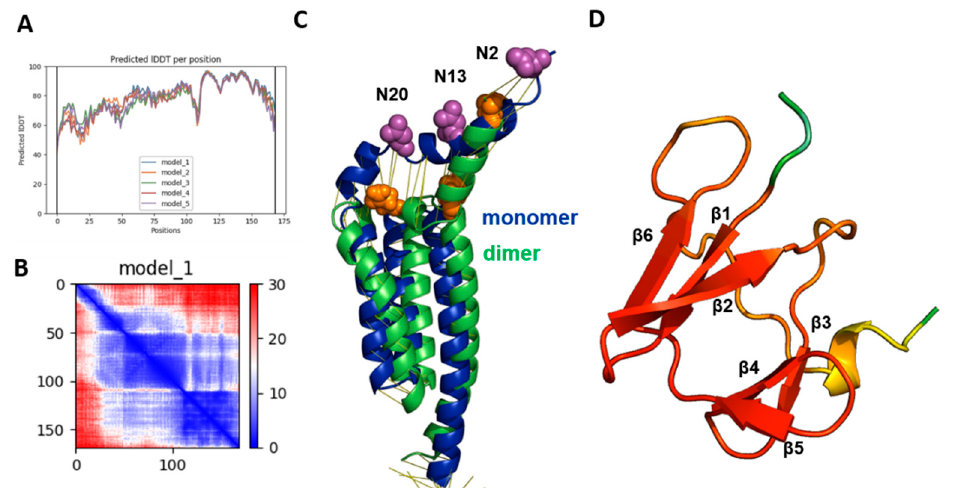
Figure 7. Possible conformational changes occurring upon dimerization of Gp5/M. ( A ) Predicted local distance difference test (LDDT) score per position for the five models generated by alphafold2 for monomeric Gp5 from VR 2332. ( B ) Prediction aligned error (PAE) score for model 1. ( C ) Alignment of the ectodomain and transmembrane region of monomeric Gp5 (blue) with the corresponding region of the Gp5/M dimer (green) from VR 2332. The N-glycosylation sites are highlighted as magenta (monomer) or orange (dimer) spheres. ( D ) Endodomain of Gp5 from VR 2332 showing the pLDDT per position in rainbow colors from red (high confidence) to blue (low confidence) and the numbering of β -sheets.